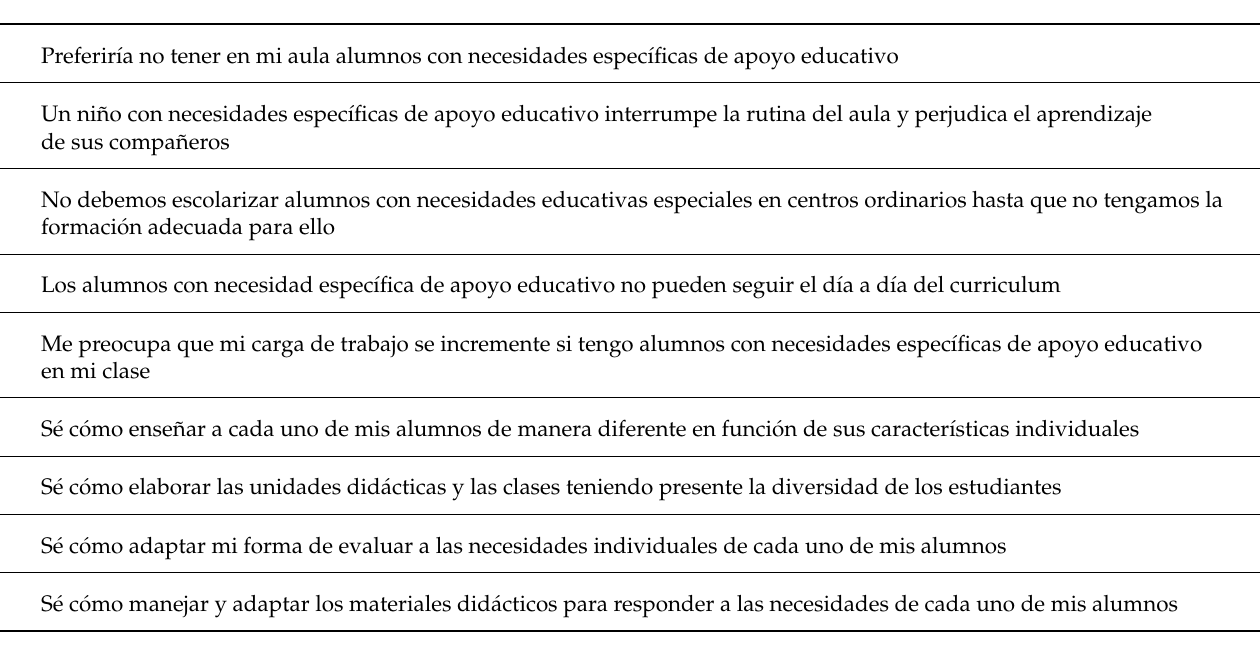
Table A1. Cuestionario para la Evaluaci ó n de la Preparaci ó n del Profesorado para la Inclusi ó n